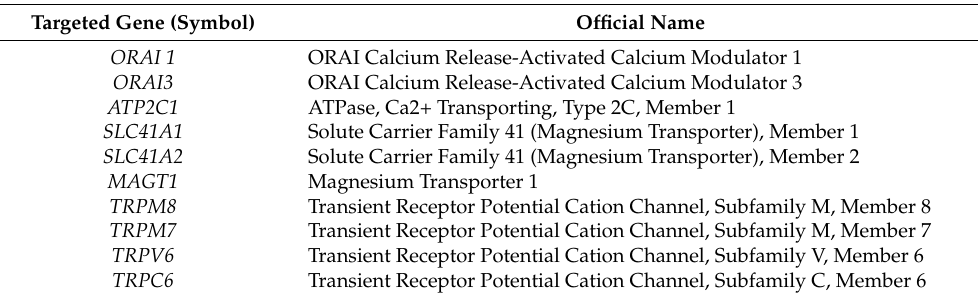
Table 1. siRNAs used in this study.